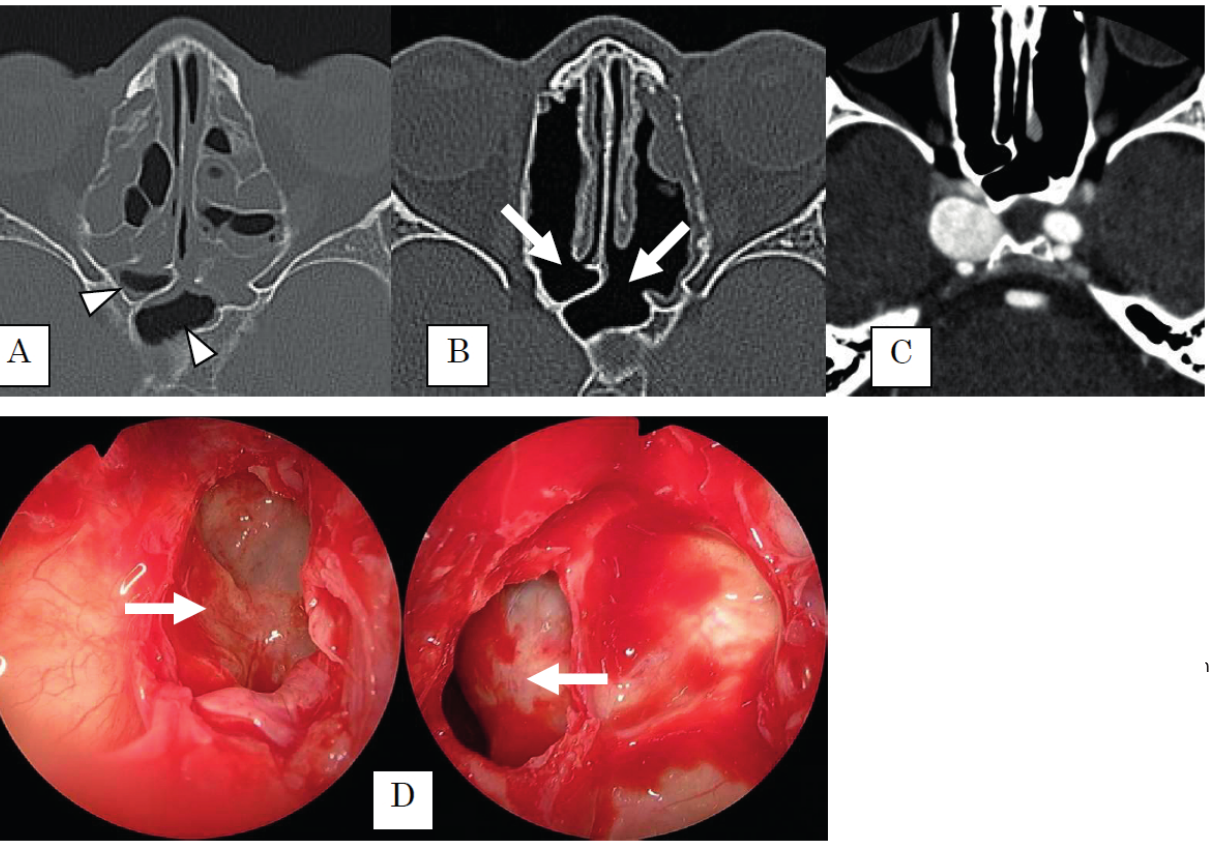
Figure 3. Preoperative and postoperative computed tomography and intraoperative endoscopic findings of the sphenoid sinus. (A) Preoperative computed tomography (CT) of the sphenoid sinus. A sphenoethmoid (Onodi) air cell is seen on the left side. Arrowheads show partial opacifications in bilateral sphenoid sinuses. (B) Postoperative CT of the sphenoid sinus. Arrows show removal of the anterior sphenoid wall, otherwise no bony destruction of the sphenoid sinus. (C) Postoperative CT with contrast enhancement shows neither bone thinning nor protrusion of the cavernous carotid aneurysm to the sphenoid sinus. (D) Intraoperative endoscopic findings of the sphenoid sinus. Arrows show bilateral sphenoid sinus with little sign of mucous